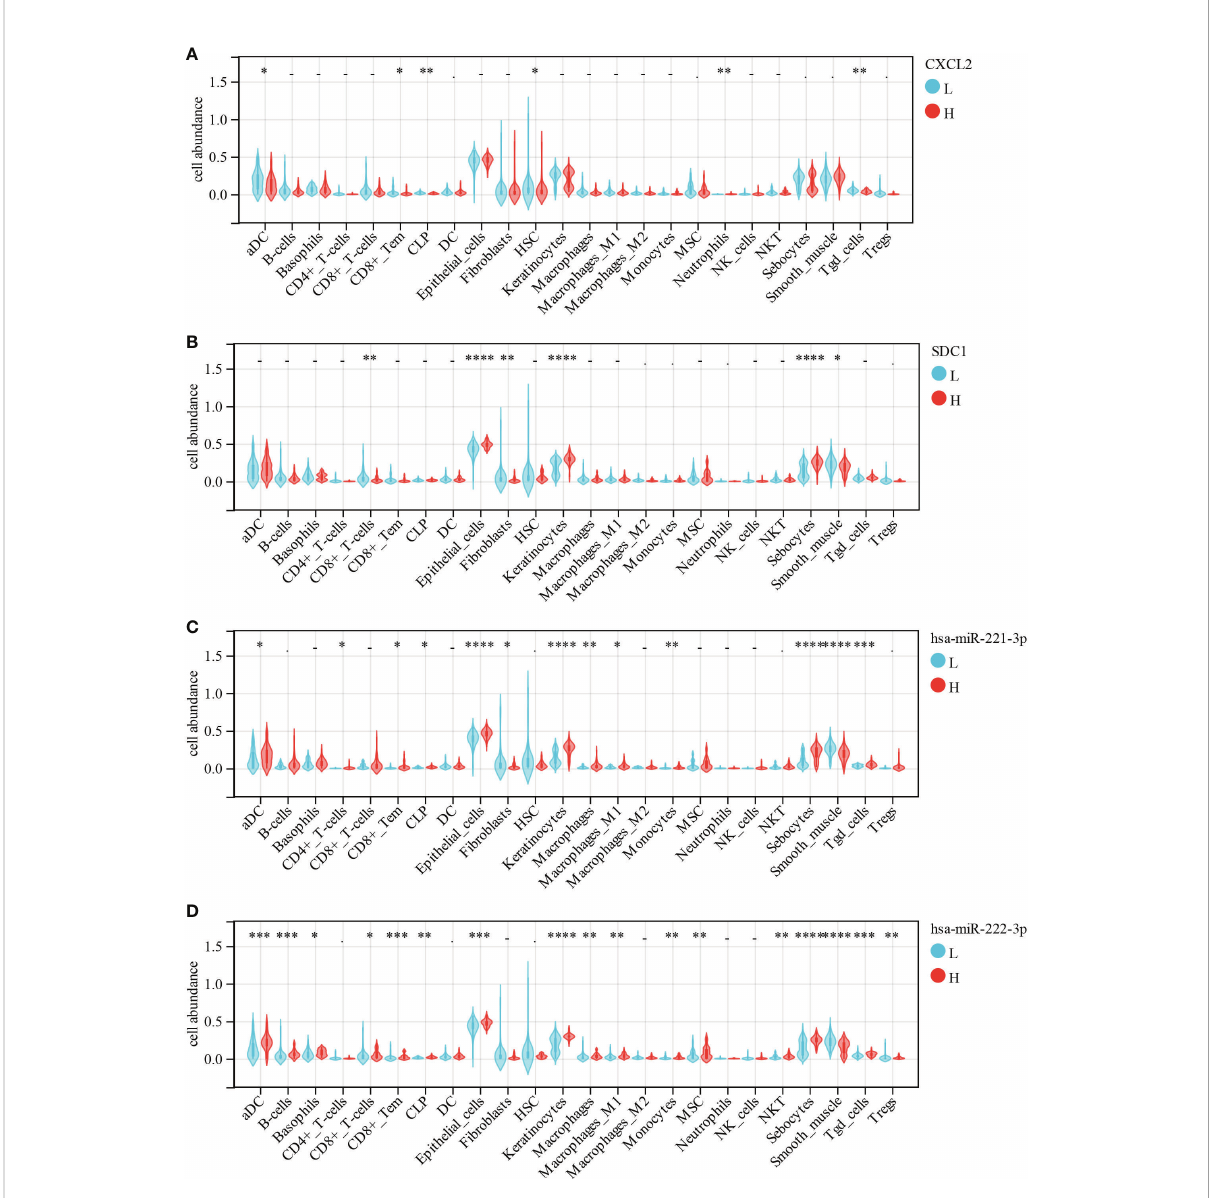
FIGURE 12 Correlations of low/high (A) CXCL2, (B) SDC1, (C) miR-221-3p and (D) miR-222-3p expression with immune cells in fi ltration in CESC. *, p < 0.05; **, p < 0.01; ***, p <